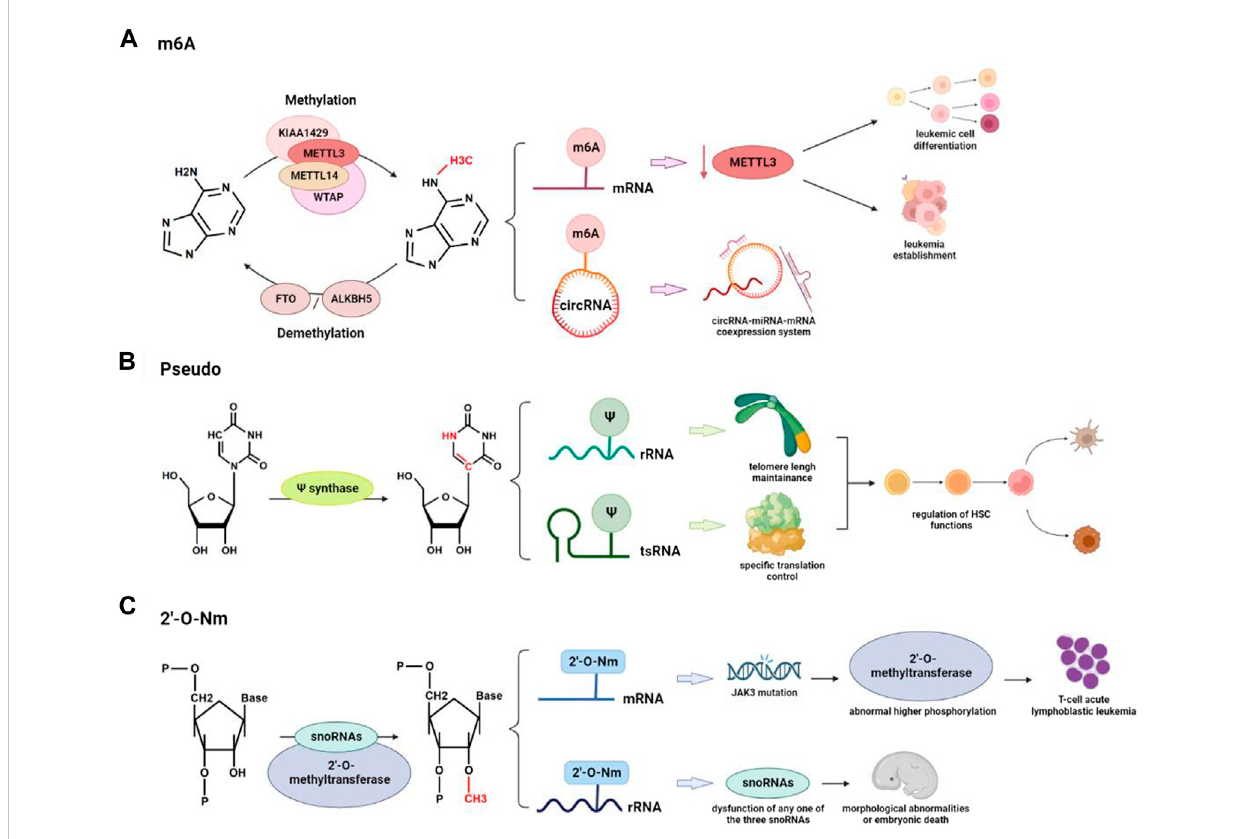
FIGURE 2 RNA modi fi cations are involved in the regulation of hematopoiesis and hematological malignancies: (A) Reversible conversion of m6A modi fi cation and differential regulation function on mRNA and circRNA in hematologic cancers. (B) Pseudo is involved in the regulation of HSC by acting on rRNA to maintain telomere length or on tsRNA to modulate speci fi c translation processes. (C) Abnormal 2 ′ -O-Nm can cause mutations in other important genes and can also lead to severe morphological abnormalities and embryonic